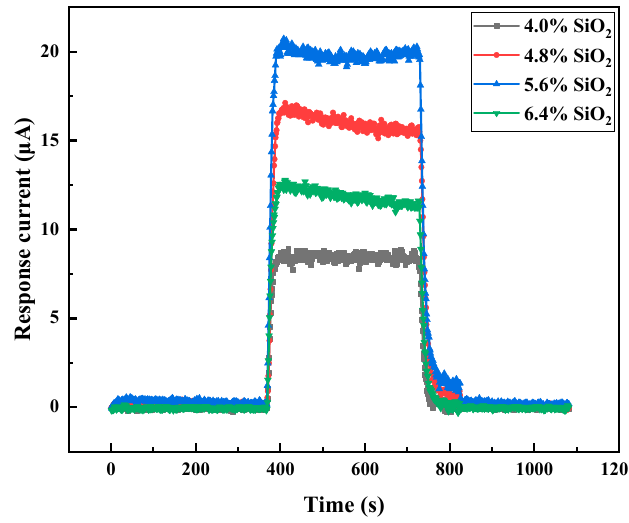
Figure 7. Effect of SiO 2 content on the response of the gel electrolyte electrochemical CO gas sensor. Test conditions: 25 °C, 50% RH, 200 ppm CO, and 1000 sccm CO.